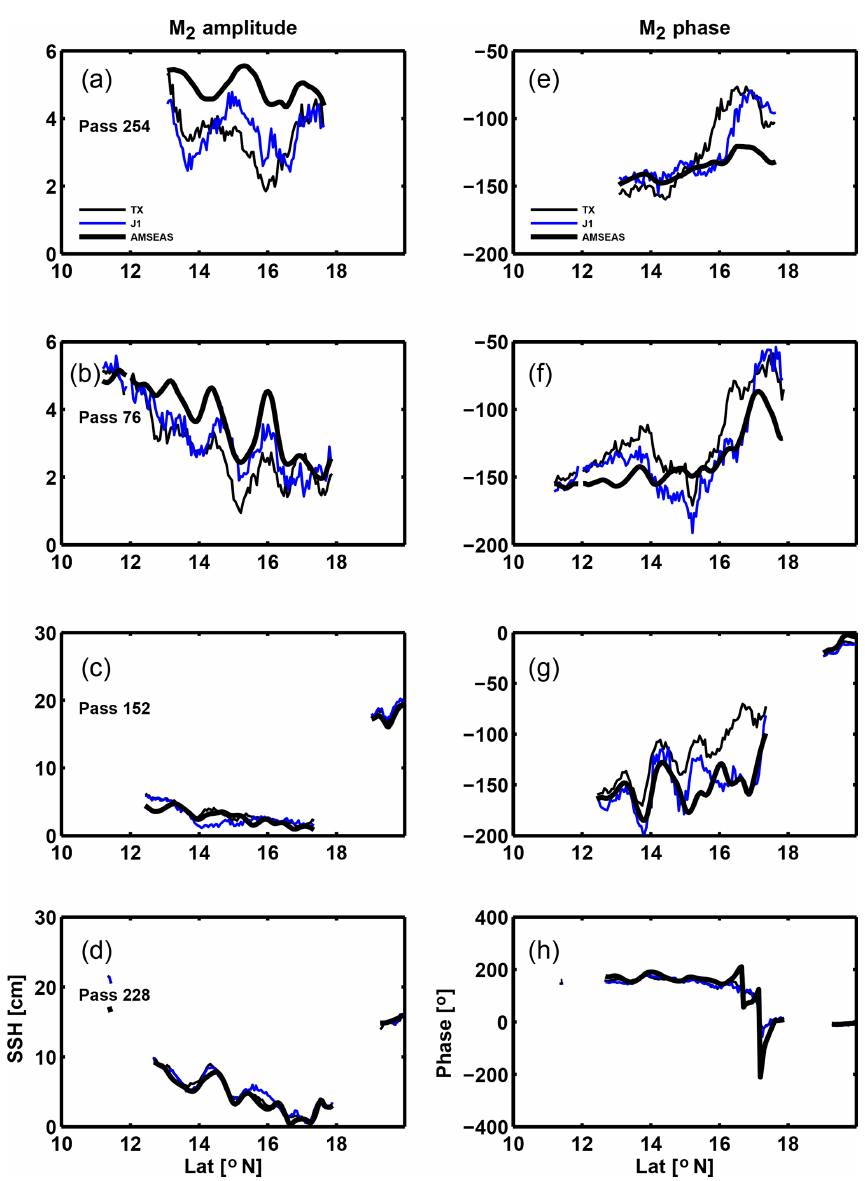
Figure A1. Comparison of satellite-derived and AMSEAS phase-locked tides in the Caribbean Sea: descending